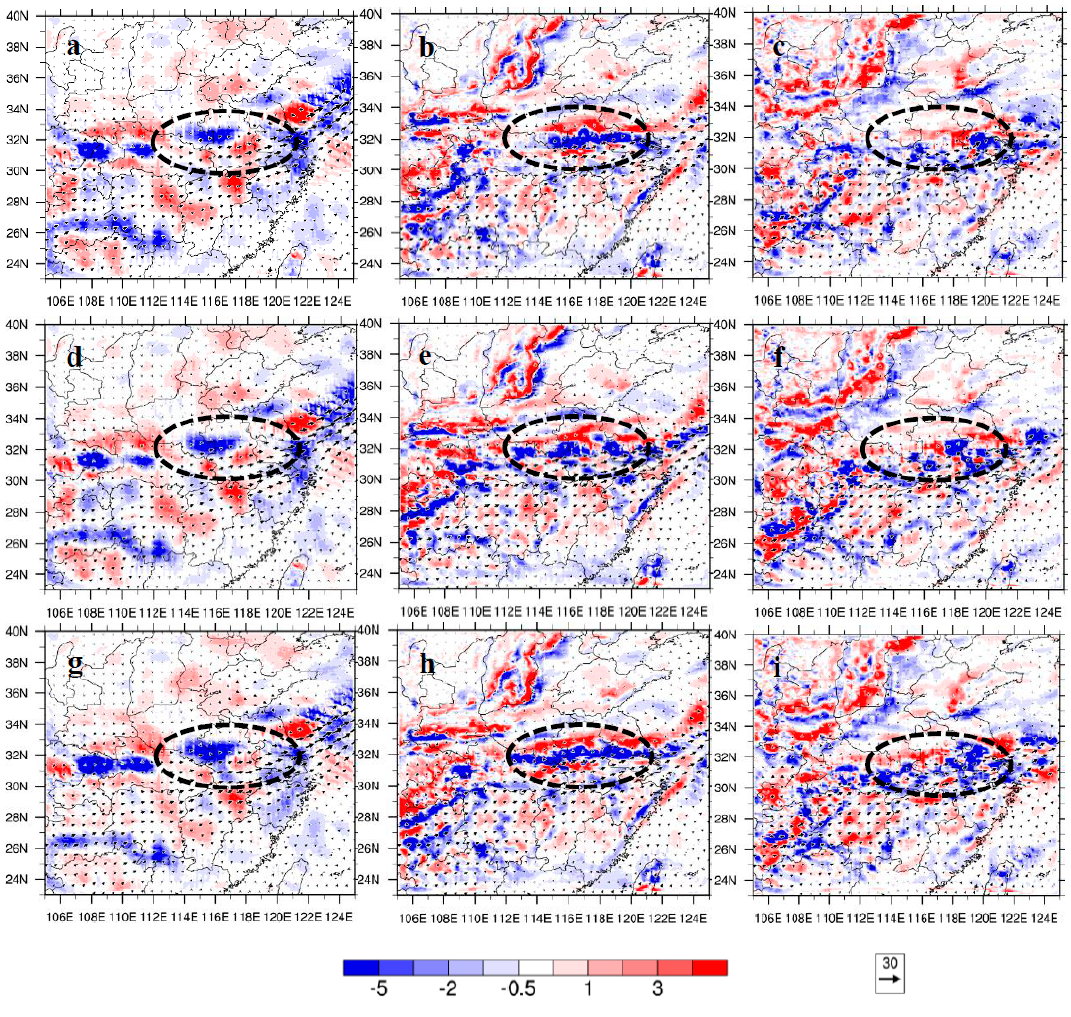
Figure 13. Water vapor flux divergence at 850 hPa of analyses ( a , d , g ) 6 h forecasts ( b , e , h ) and 12 h forecasts ( c , f , i ) for conv4dvar ( a – c ), pcp4dvar ( d – f ), and convpcp4dvar ( g – i ) initialized at 0600 UTC 05 July 2013. The shades present the magnitude of divergence and the vectors present the direction of the water vapor